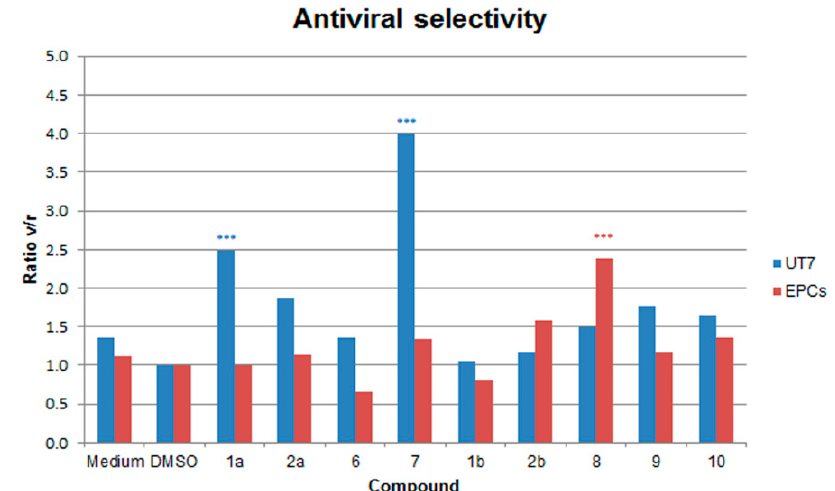
Figure 4. Selectivity of inhibition of B19V replication relative to cell viability (ratio v/r), each compared to medium with 1% DMSO. Data were collected from duplicate experiments; the statistical analysis was performed by one-way ANOVA (analysis of variance) followed by Dunnett’s multiple comparison test (control medium with 1% DMSO). *** p value < 0.0001.